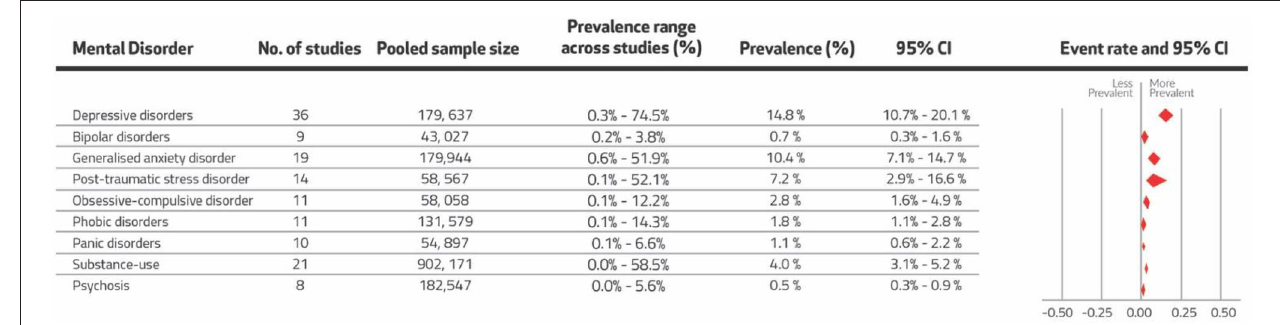
FIGURE 2 | Random-effects pooled point prevalence estimates for mental